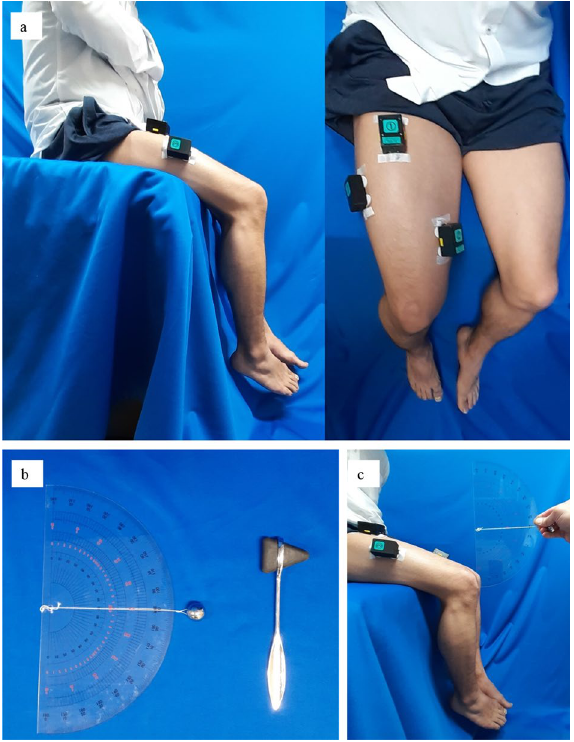
Figure 3. ( a ) Sensors and attachments. Three sensors were placed on the quadriceps, rectus femoris, vastus medialis, and vastus lateralis muscles. ( b ) Hammer (right) and the tool (left) used to evoke the patellar tendon reflex. ( c ) An iron ball was attached using string to a goniometer and the iron ball was dropped from 90° onto the patellar tendon using gravity.